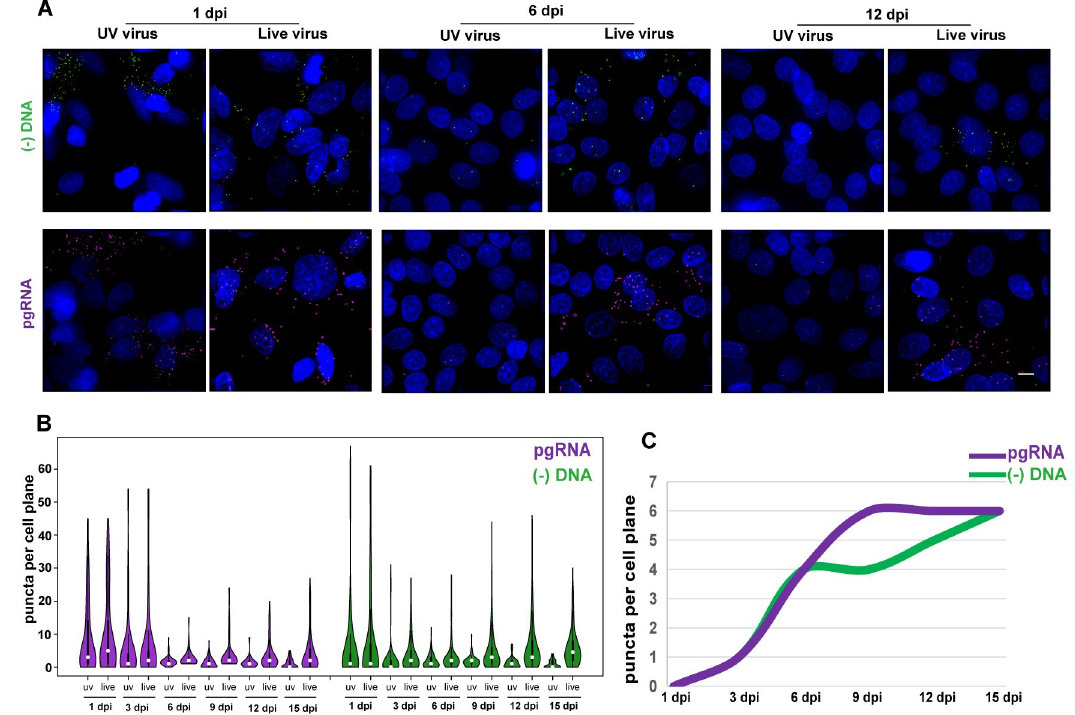
Fig 2. Kinetics of HBV DNA and RNA accumulation during infection. (A) HepG2-NTCP cells were infected with UV-irradiated or untreated HBV at MOI = 1000. At the indicated times post-infection, cells were fixed and processed for FISH detection. Scale bar, 4 μ m. (B) Individual pgRNA and (-) DNA puncta for each time point were quantified and graphed using the R package. More than 100 cells per group were counted. (C) The median of the true pgRNA and (-) DNA signal (live virus signal subtracted by UV virus signal) over the indicated time post-infection were plotted using the smooth graph function in Microsoft